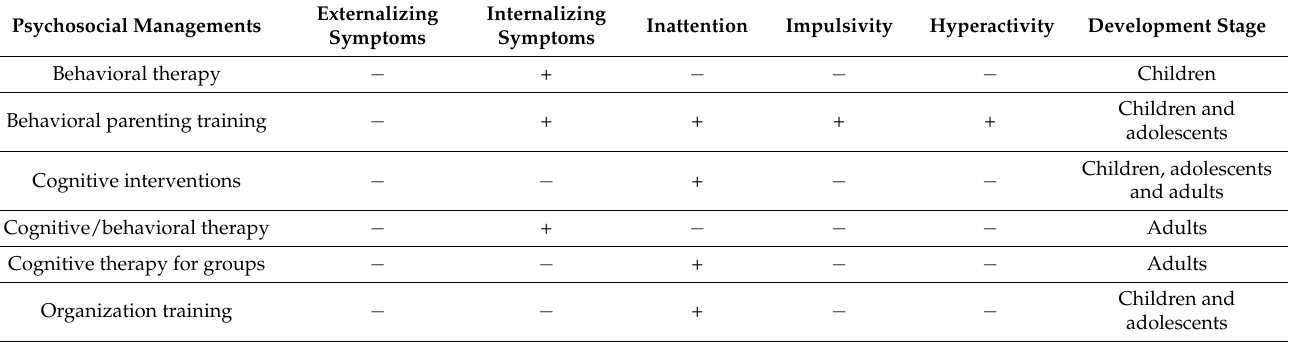
Table 5. Psychosocial Treatments Evidence in